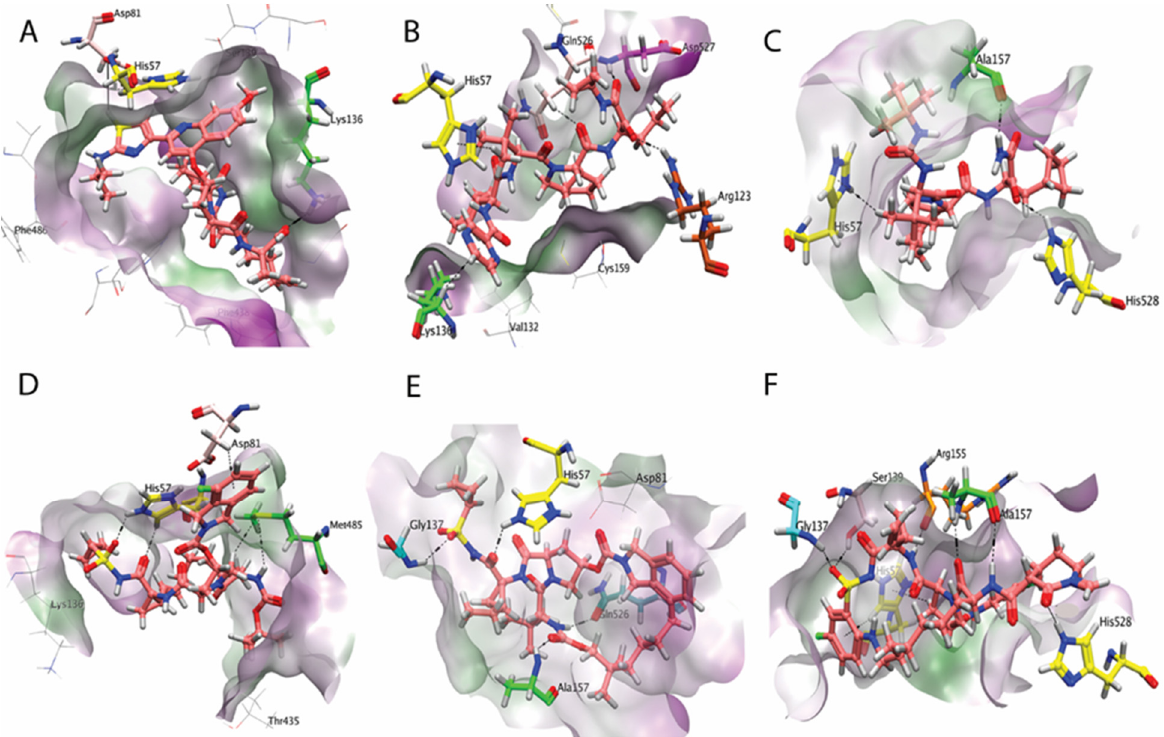
Figure 4. 3D docked conformations of the original data set inhibitors in the active site of HCV NS3/4A protease. ( A ) The predicted binding mode for the inhibitor BILN2061. ( B ) The predicted docking pose of VX-950. ( C ) The inhibitor SCH-503034 binding mode. ( D ) The inhibitor ITMN-191 binding mode. ( E ) The predicted docking mode of MK-7009. ( F ) The predicted docking pose of a macrocyclic full-length inhibitor. The ligands are shown in orange color. The purple-colored surface shows hydrophilic surface area, whereas the greenish colored surface shows the lipophilic surface area of the active site.